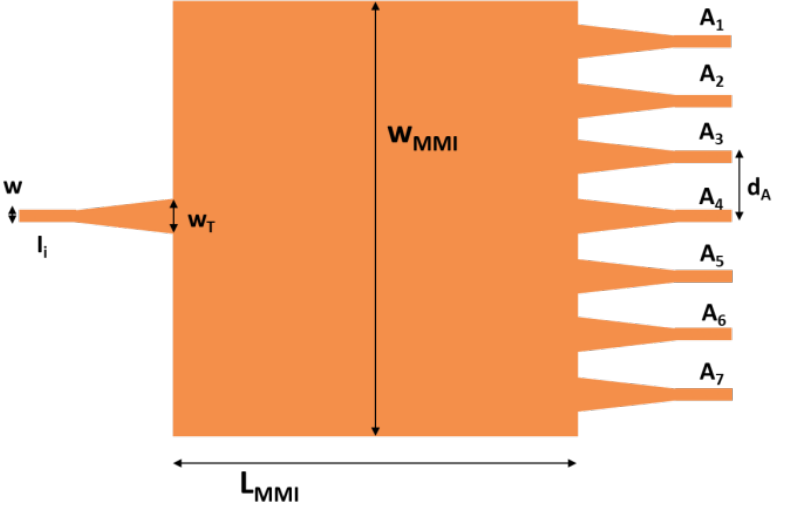
Figure 6. Scheme of the 1 × 7 MMI beam splitter. The waveguides are made of silicon, and the same multilayer of the OWS is considered in the simulations with the UV26 cladding thickness t = 1 µ